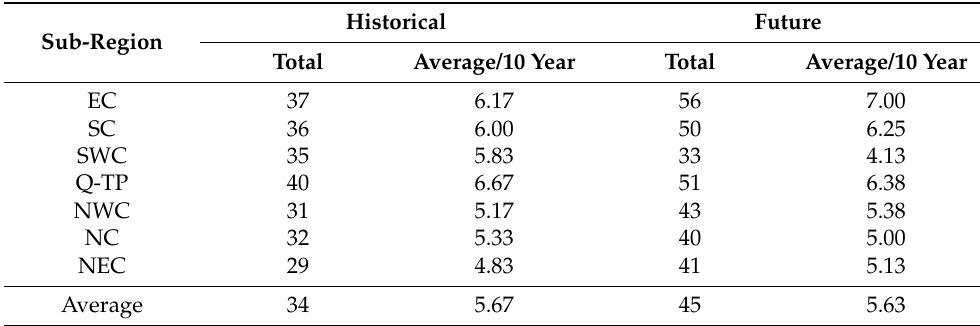
Table 5. Drought numbers in each sub-region during the historical period (1961–2020) and the future period (2021–2100).